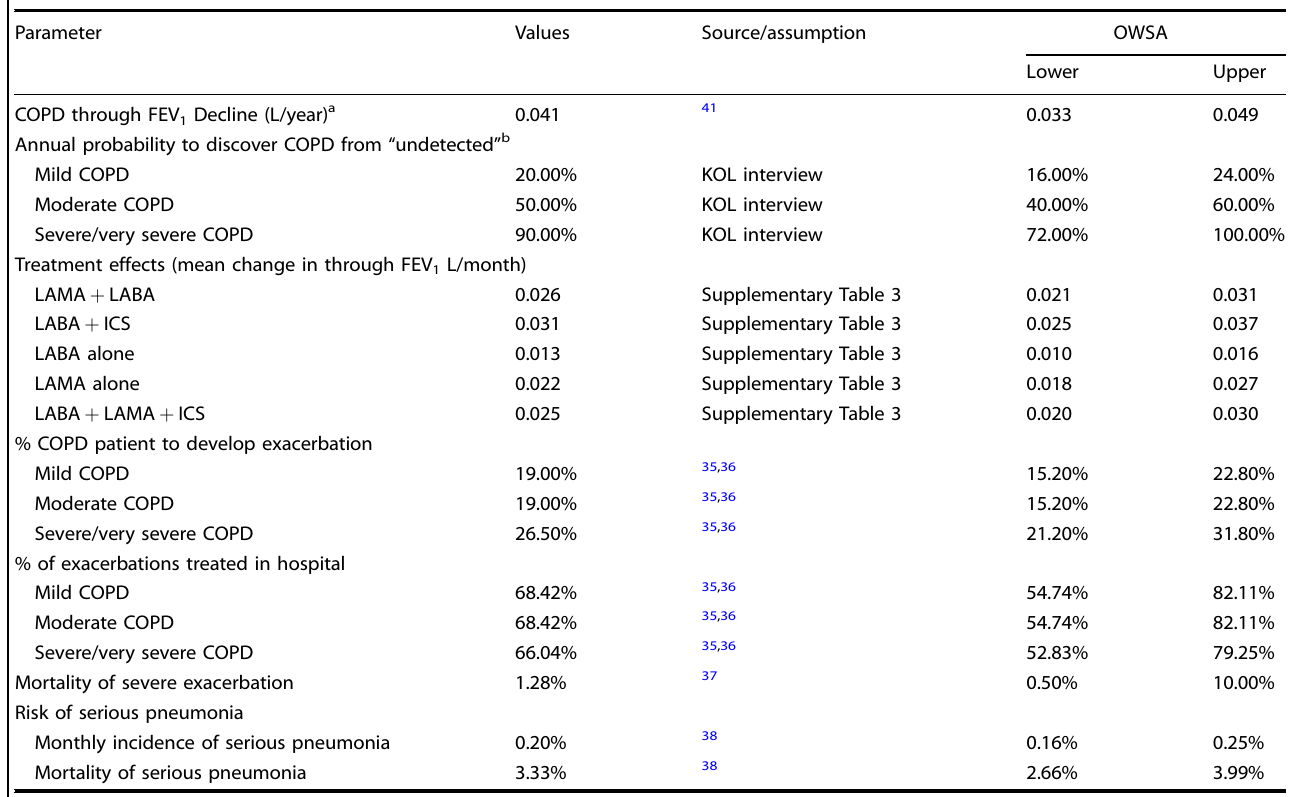
Table 4. Clinical inputs.